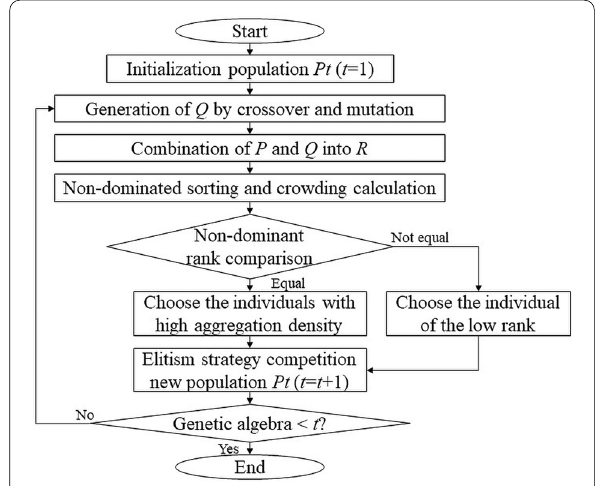
Fig. 2 Flowchart of NSGA2